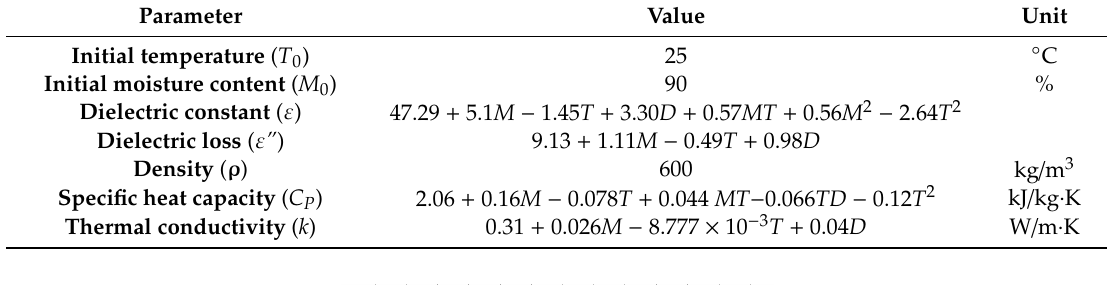
Table 7. The input parameters of berry puree used in the simulation model.